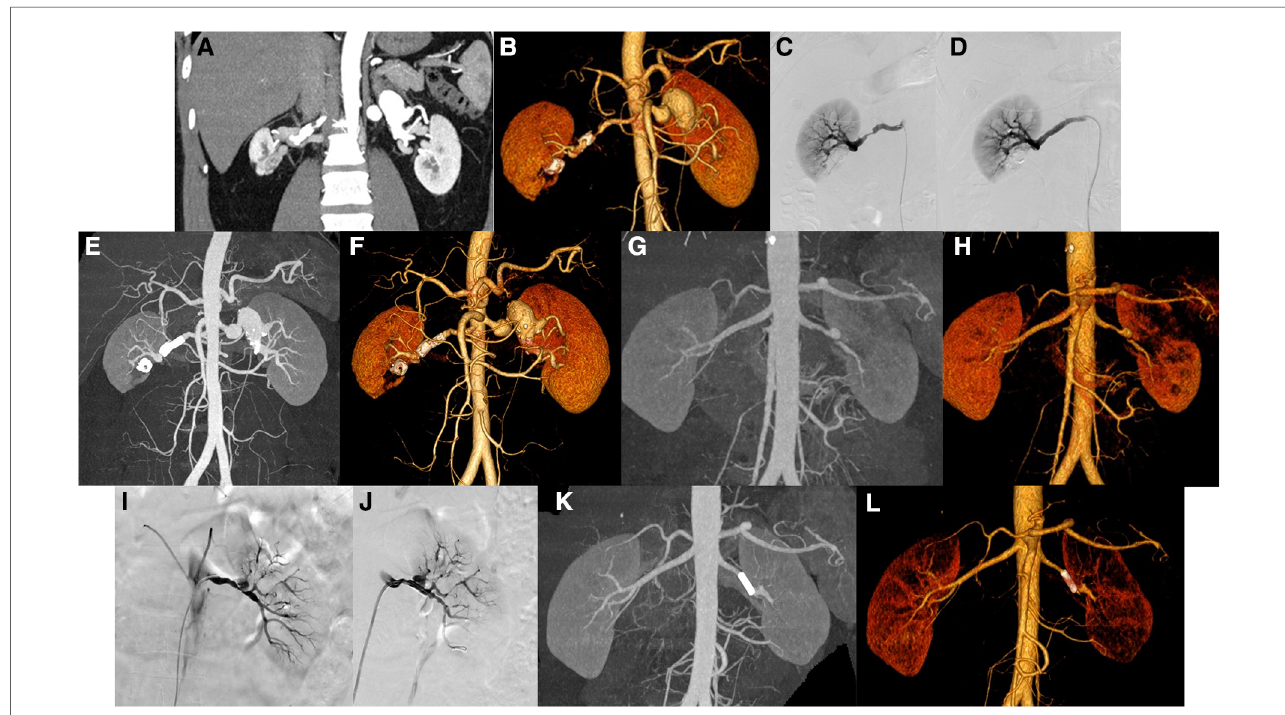
FIGURE 3 Patients no. 12 with renal aneurysms: ( A,B ) Computed tomography (CT) showed the main aneurysms of both renal arteries, with partial mural thrombosis and partial wall calci fi cation, of which the main left renal artery is obvious (the widest part is approximately 2.5 cm in diameter). There are low-density foci in the lower right kidney near the renal sinus, with circular calci fi cation at the edge, and adjacent right renal parenchyma with atrophy and ischemia. ( C,D ) The left and right renal arteries were performed, and frontal imaging (digital subtraction angiography) showed that the middle and distal parts of the left renal artery are enlarged (approximately 2.1 cm in diameter), involving intrarenal branches. There is approximately 60% – 70% stenosis in the middle and distal part of the right renal artery, and the stenosis improved after stent implantation. ( E,F ) Three months later, CT showed that the stent lumen of the right renal artery is unobstructed. Patients no. 10 with renal aneurysm: ( G,H ) CT showed local dissection or formation of an aneurysm in the main trunk of the left renal artery and multiple ischemic abnormal enhancement areas in the left kidney. ( I,J ) Left renal artery angiography showed that the distal part of the left renal artery is approximately 80% – 90% stenosis and a mung bean-sized aneurysm was observed. There is also 70% – 90% stenosis in multiple branches of the left kidney. After stent implantation, the stenosis of the left renal artery is improved and covered the neck of the aneurysm. ( K,L ) CT scan 1 year after the operation showed that the left renal artery stent is in place, and the lumen is